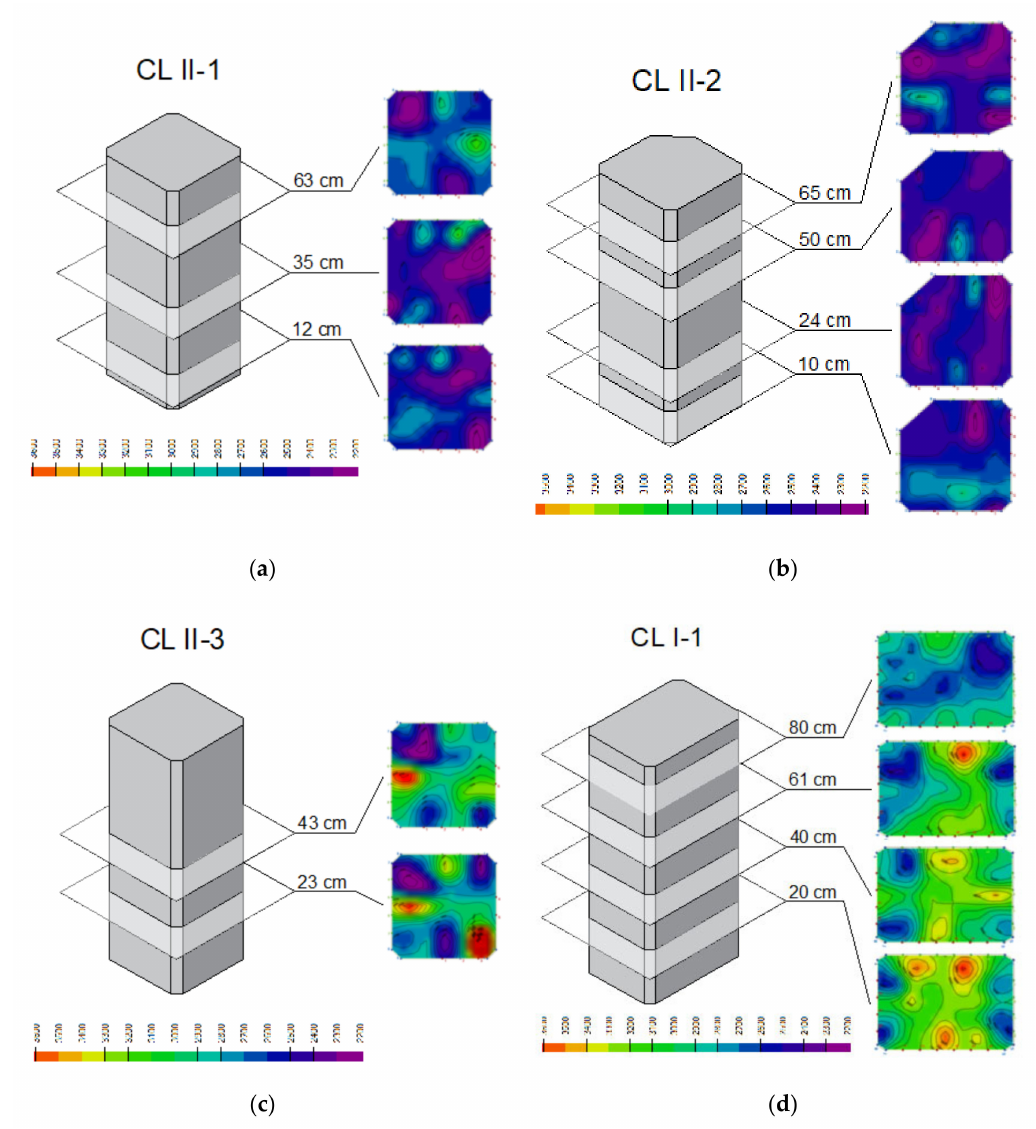
Figure 6. Tomographic maps of the column elements: ( a ) specimen CL II-1; ( b ) specimen CL II-2; ( c ) specimen CL II-3; ( d ) specimen CL